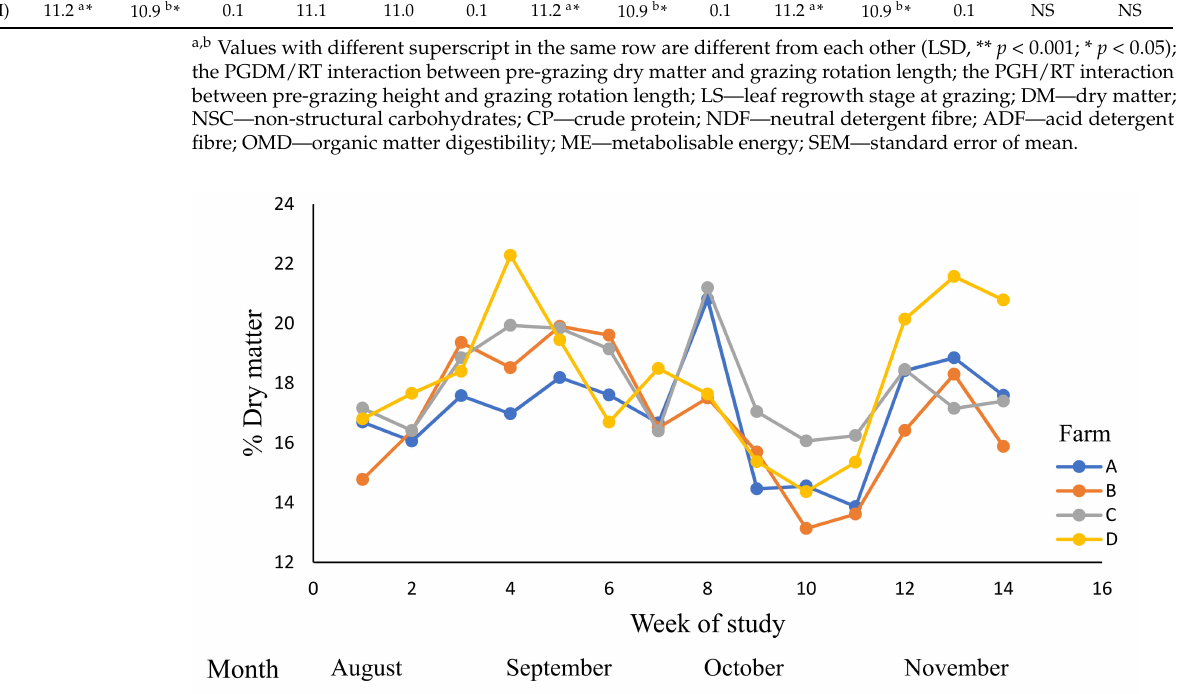
Figure 1. The variations in the dry matter (DM) content (%) of pasture across dairy farms (A–D) during winter and spring; 0–14 weeks (August to November